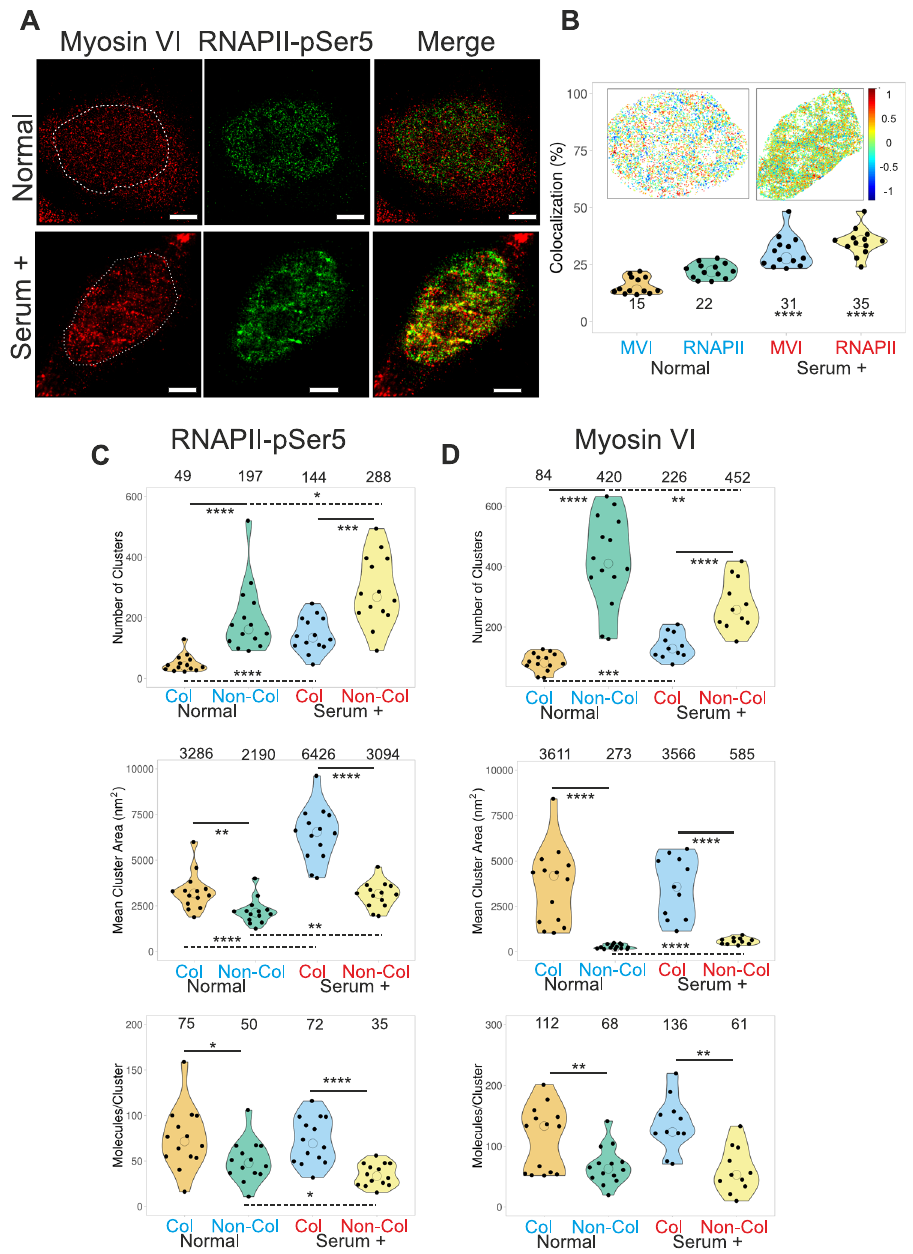
Fig. 2 Nuclear organisation of RNAPII and colocalization with Myosin VI. A Example STORM render image of MVI and RNAPII-pSer5 under normal conditions and serum-treated conditions (scale bar 2 μ m). B Co-localisation analysis of MVI and RNAPII-pSer5 clusters under normal and serum-treated conditions. Inset is a representative cluster colocalization heatmap whereby DoC values of 1 are perfectly colocalised and − 1 are separated from each other. Individual data points represent the percentage of each protein which is colocalized based on DoC threshold of above 0.4 ( n = 13) (see Fig. S6 for example histograms). The values represent the mean from the ROIs for each protein (Only statistically signi fi cant changes are highlighted **** p < 0.0001 by two-tailed t test compared to normal conditions for each protein). C Cluster analysis of RNAPII-pSer5 nuclear organisation under normal and serum- treated conditions. The data are broken down into myosin VI colocalized and non-colocalized clusters. Individual data points correspond to the average value for a cell ROI ( n = 14). The values represent the mean from the ROIs for each condition (Only statistically signi fi cant changes are highlighted * p < 0.05; ** p < 0.01; *** p < 0.001; **** p < 0.0001 by two-tailed t test compared to normal conditions). D Cluster analysis of myosin VI nuclear organisation under normal and serum-treated conditions. The data are broken down in to RNAPII-pSer5 colocalized and non-colocalized clusters. Individual data points correspond to the average value for a cell ROI ( n = 14). The values represent the mean from the ROIs for each condition (Only statistically signi fi cant changes are highlighted ** p < 0.01; *** p < 0.001; **** p < 0.0001 by two-tailed t test compared to normal